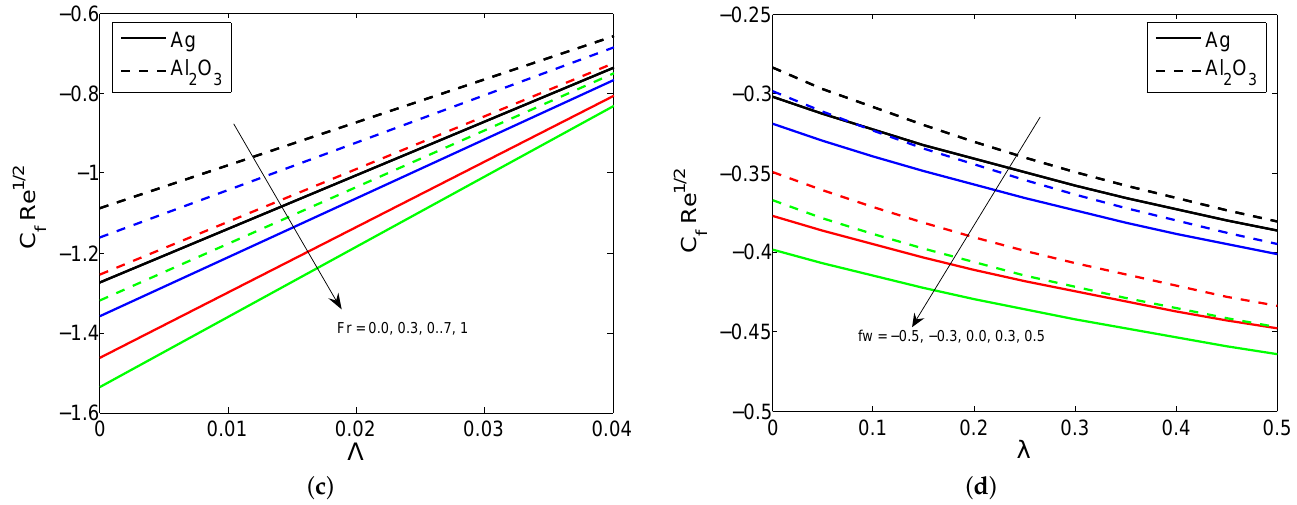
Figure 6. SFC variation for diverging values of ( a ) Fr & λ , ( b ) Fr & fw , ( c ) Fr & Λ and ( d ) fw & Λ .